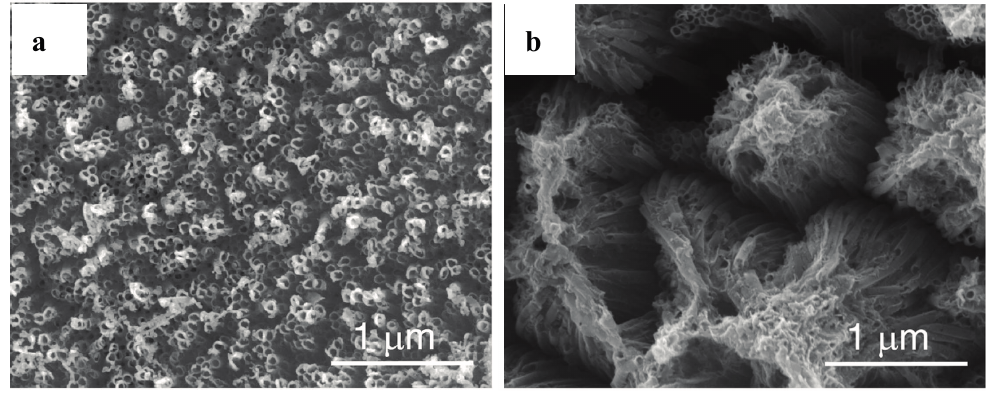
Figure 8. Scanning electron microscopy images of TNT films that were cleaned with either ( a ) ethanol or ( b ) water, and then either (a) supercritical CO 2 -dried or (b) air-dried. Reproduced with permission from reference